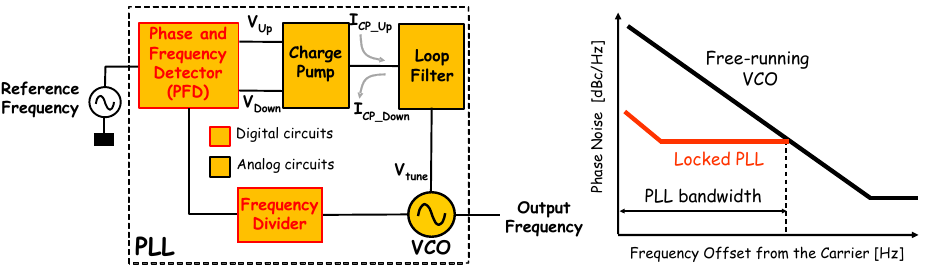
Figure 1. Typical building block diagram of a PLL (on the left ) and phase noise shaping under locked conditions (on the right ).